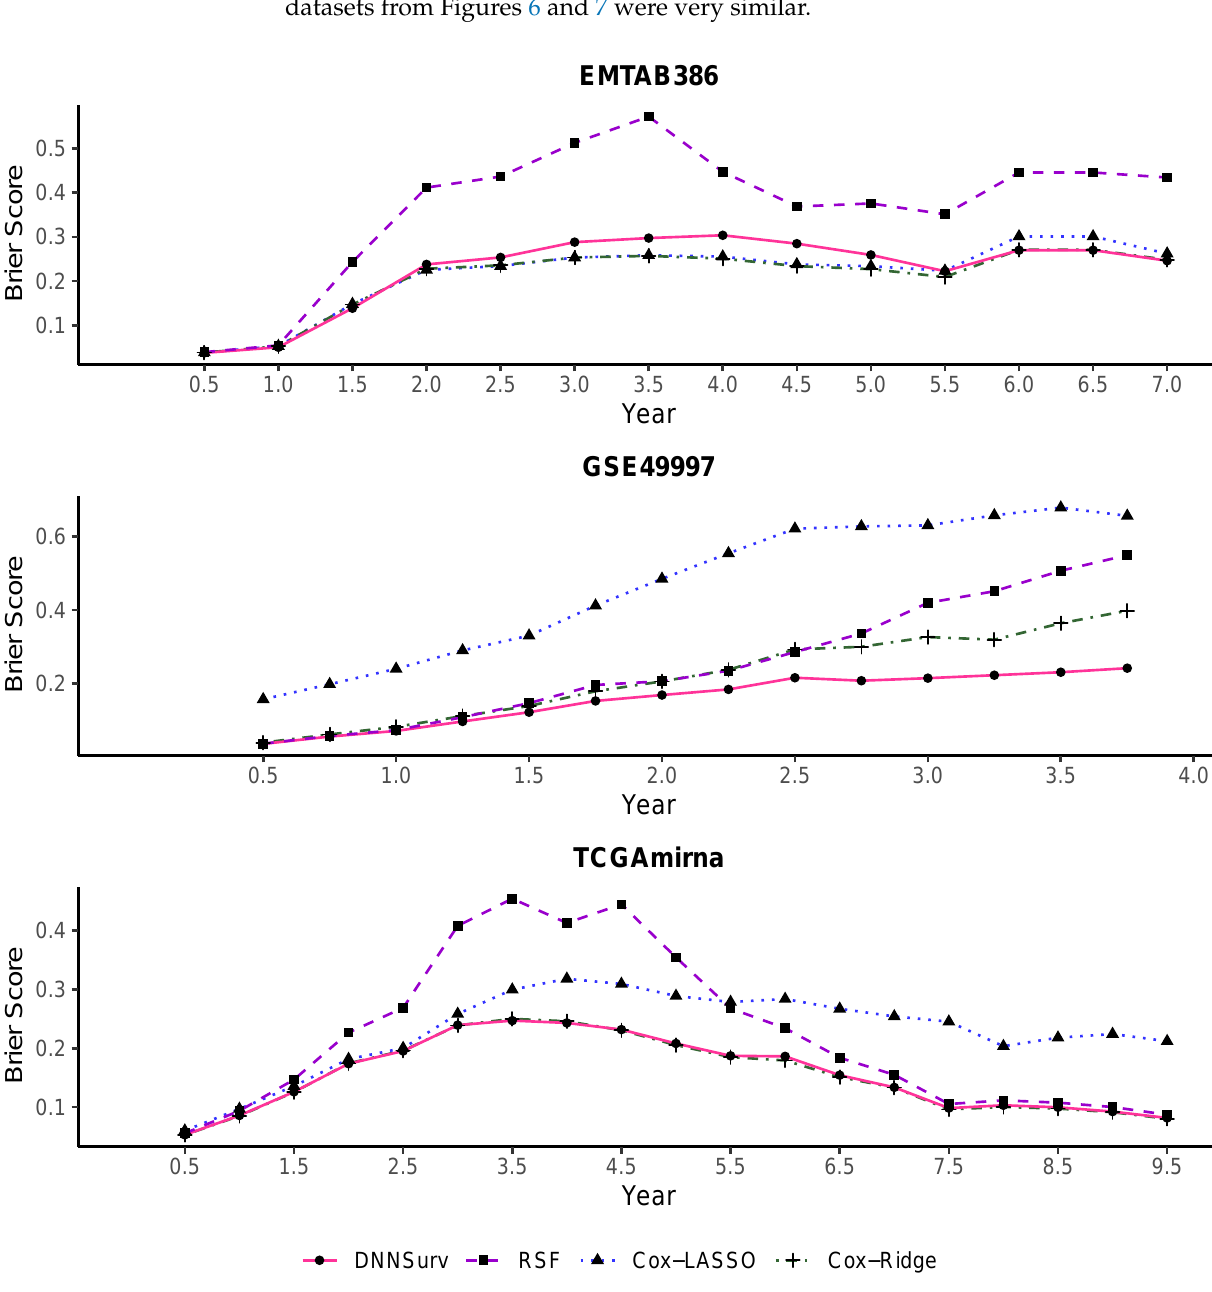
Figure 6. The time-dependent Brier score for all four models on three test datasets that contain gene features only